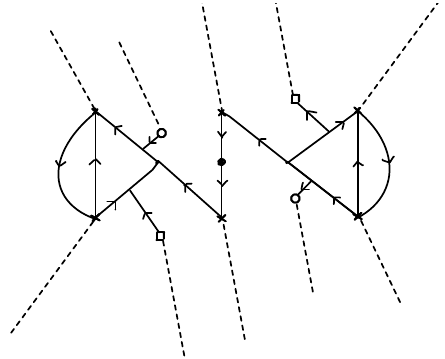
Figure 3 . An intermediate step towards the irreducible representative of the string junction for (cid:27) .